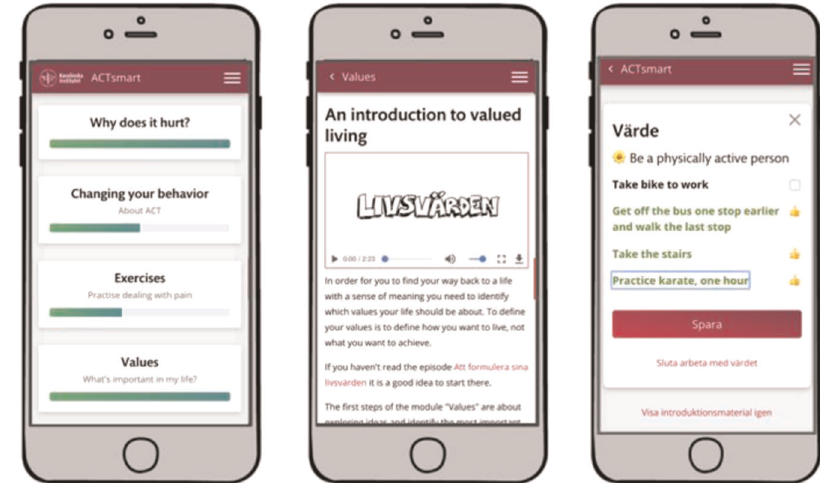
Fig. 8 Screenshot of patient interface, home screen, introduction to values, and values work section.